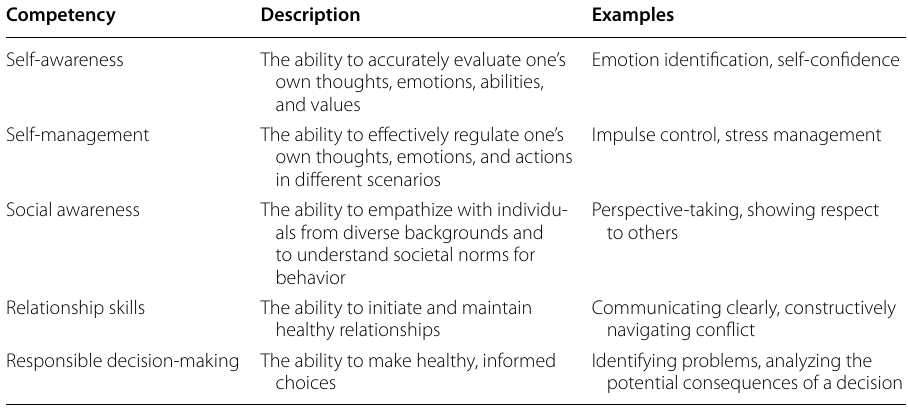
Table 1 SEL core competencies (CASEL